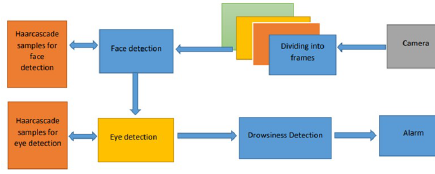
Figure 1: Proposed Methodology